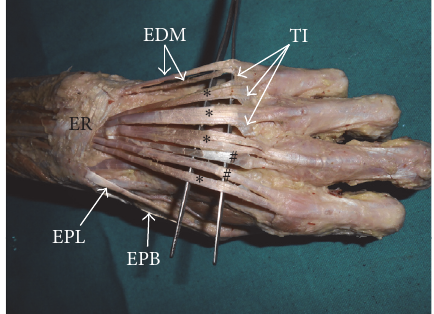
Figure 1: Lateral view of the dorsum of hand showing the superficial branch (SB) of radial artery (RA). (EDL: extensor digitorum; ECRL: extensor carpi radialis longus; EPL: extensor pollicis longus; FDI: first dorsal interosseous; PPA: princeps pollicis artery; RIA: radialis indicis artery).